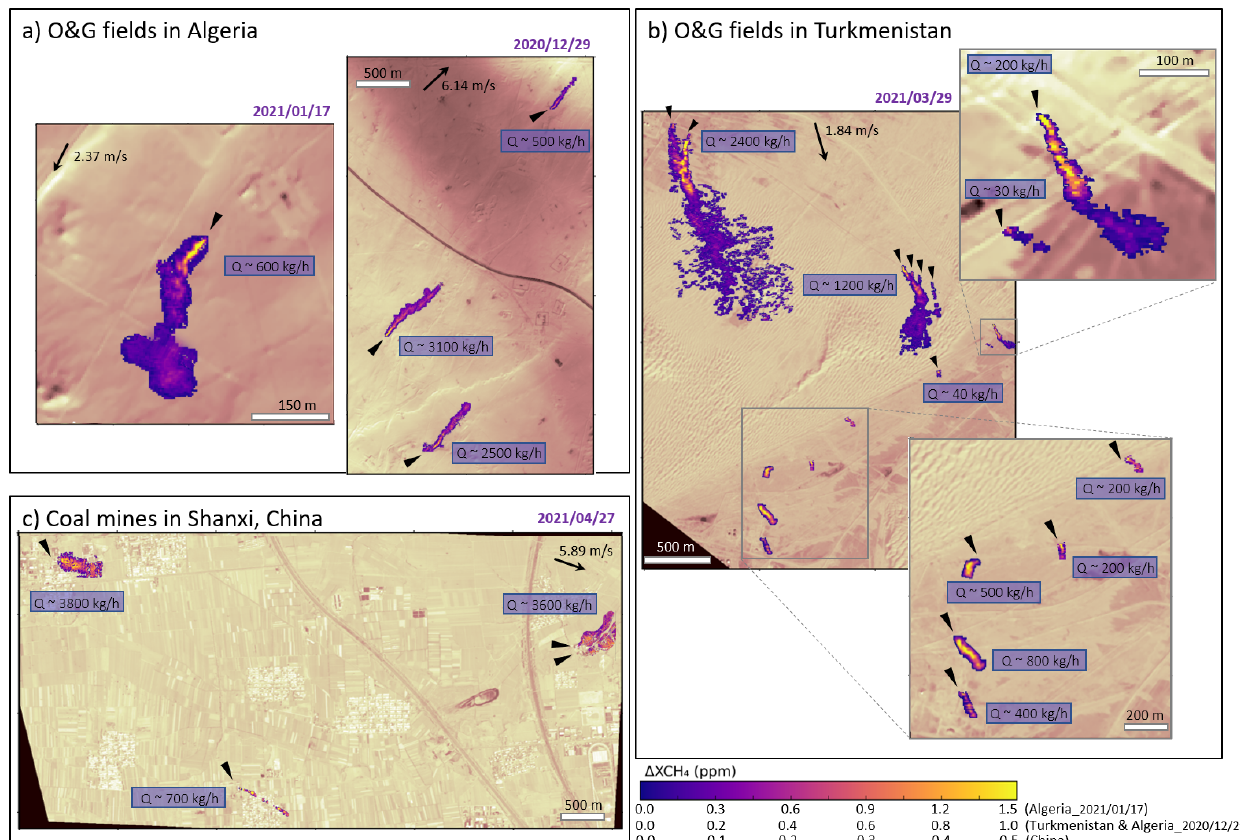
Figure 13. (cid:49) XCH 4 maps from plumes detected in real WV-3 images acquired in three different parts of the world. (a) Emitters from Hassi Messaoud oil field in Algeria on 17 January 2021 (pipeline: 31.742 ◦ N, 5.895 ◦ E), and on 29 December 2020 (pipelines from left to right located in 31.778 ◦ N, 5.995 ◦ E; 31.768 ◦ N, 6.000 ◦ E; and 31.797 ◦ N, 6.011 ◦ E; detailed in Fig. 15). (b) Emitters from Goturdepe O&G field in Turkmenistan North on 29 March 2021 with 14 plumes located along the pipelines: two-point source emitters NW of the image (39.498 ◦ N, 53.636 ◦ E and 39.497 ◦ N, 53.638 ◦ E); four plumes around 39.485 ◦ N, 53.663 ◦ E (detailed in Fig. 14); those further east zoomed around 39.480 ◦ N, 53.671 ◦ E; and the smaller southern in the surrounding of 39.469 ◦ N, 53.649 ◦ E. (c) Emitters from Coal mines in Shanxi China on 27 April 2021 from left to right: Xiligaocun (36.2574 ◦ N, 112.9227 ◦ E); Taoyuancun (36.2337 ◦ N, 112.9458 ◦ E), Wangzhuang Beili two-point source emitters (36.2470 ◦ N, 112.9886 ◦ E and 36.2461 ◦ N, 112.9894 ◦ E). Band 1 of the © WV-3 SWIR images is used as a background.